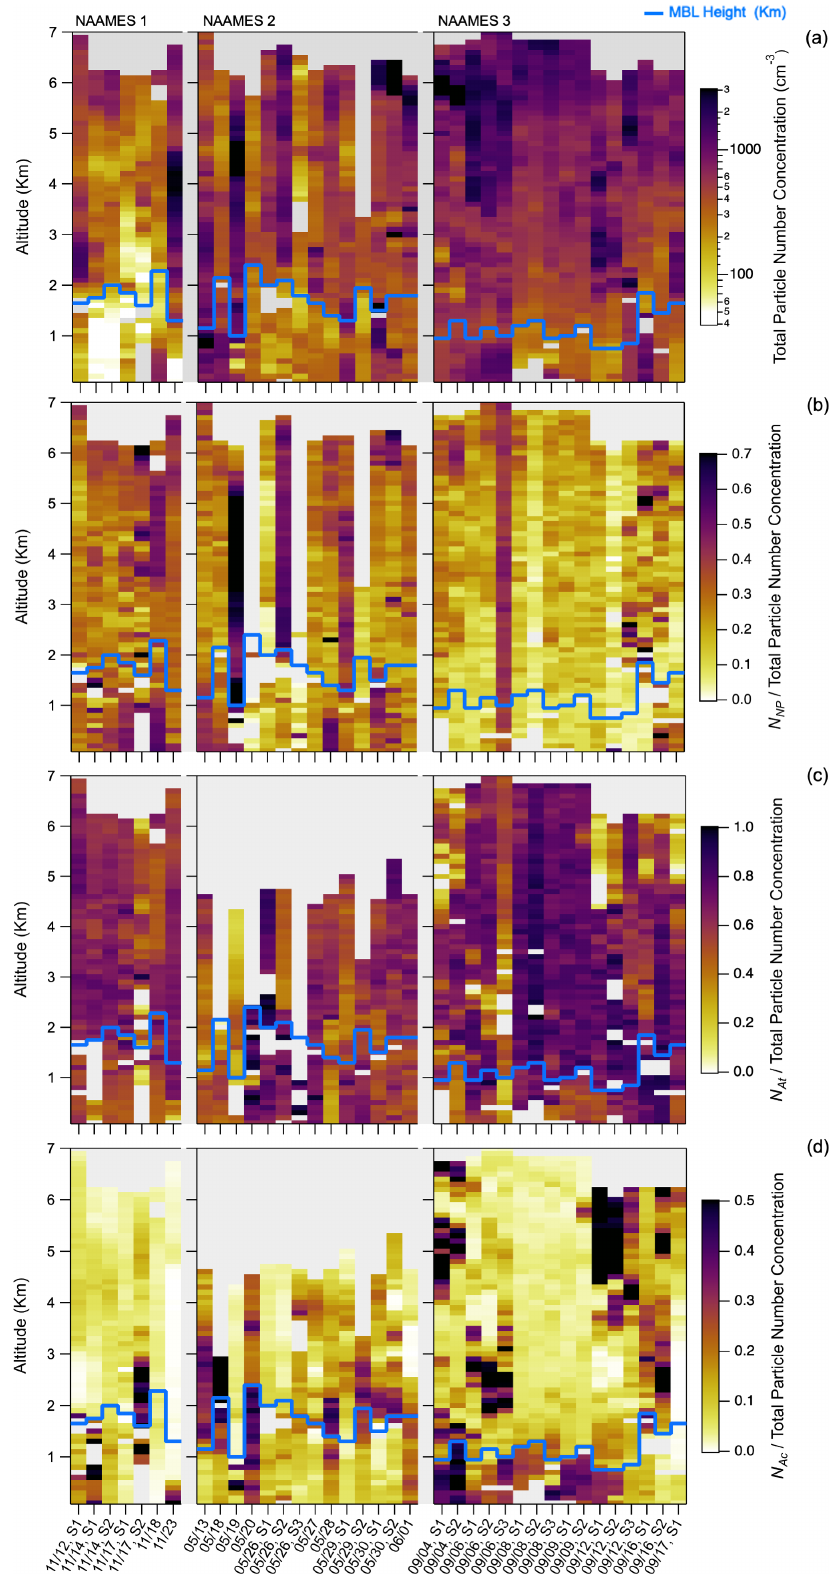
Figure 10. Vertical profile of N CN (a) , N NP /N CN (b) , N At /N CN (c) , and N Ac /N CN (d) during NAAMES-1, NAAMES-2, and NAAMES-3.